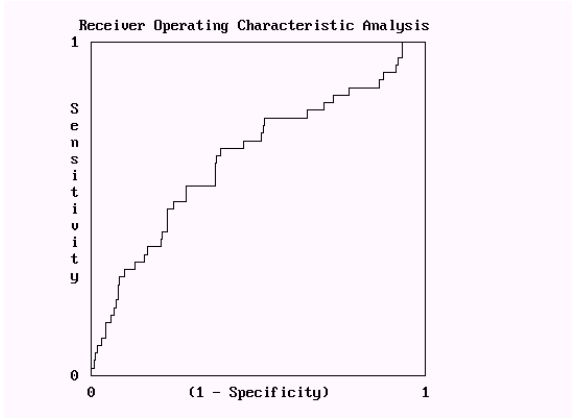
FIGURE 2B . ROC curve mortality within 90 days of discharge RBF. Test data: _____ AZ: